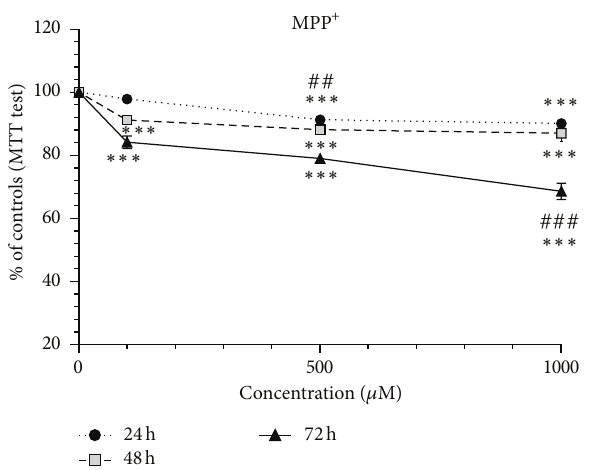
Figure 2: MPP + -induced mitochondrial dysfunction in differenti- ated SH-SY5Y. The cells were incubated with 100, 500, and 1000 𝜇 M of MPP + , and the MTT test was performed at 24, 48, and 72 h time-points. Mitochondrial dysfunction in differentiated SH-SY5Y cells evaluated by the MTT test. The viability of untreated control cells was set to 100%, and all treatments were expressed as the percentage of the respective controls (results were pooled from 3 different experiments, each experiment having 6 different culture wells per condition). The means were compared using the two- way ANOVA, followed by the Bonferroni post hoc test ( ∗∗∗ 𝑃 < 0.001 concentration versus control; ## 𝑃 < 0.01 , ### 𝑃 < 0.001 concentration versus